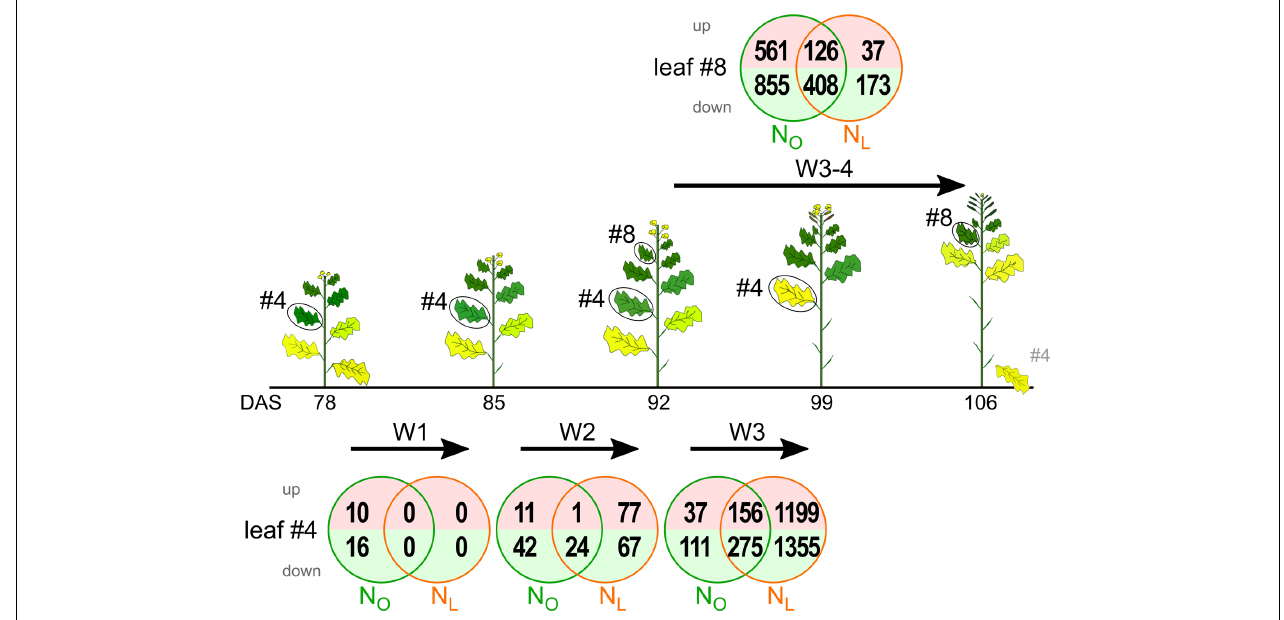
FIGURE 1 | Transcriptome changes in oilseed rape leaf 4 (#4) and leaf 8 (#8) during development under optimal N supply (N O ) and low N supply (N L ). Leaves #4 and #8 were harvested between 78 and 106 days after sowing (DAS) as indicated below the sketches of the oilseed rape plants. The Venn diagrams display the numbers of upregulated and downregulated genes highlighted in light red and lime green, respectively. The examined developmental intervals are termed week 1 (W1), week 2 (W2), week 3 (W3) and weeks 3 + 4 (W3–4). Depicted are genes with significant, ≥ 3-fold expression changes ( P adj < 0.05, n = 3).